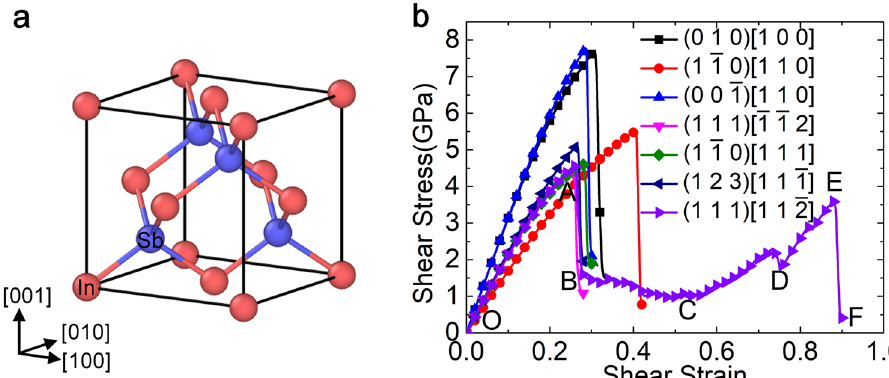
Fig. 1 Structure of InSb and shear stress response. a The structure of InSb with sketch map of double face centered cubic (fcc) lattice, the red atoms are In and the blue atoms are Sb. b The shear stress – strain curve of seven different slip systems. The shear stress – strain curve of the ð 111 Þ½ 112 (cid:2) slip system (the purple one) is partitioned into fi ve stages: O – A: elastic stage; A – B: stress dropping stage; B – C – D: structural yielding stage; D – E: structural strengthening stage; E – F: structural failure stage.